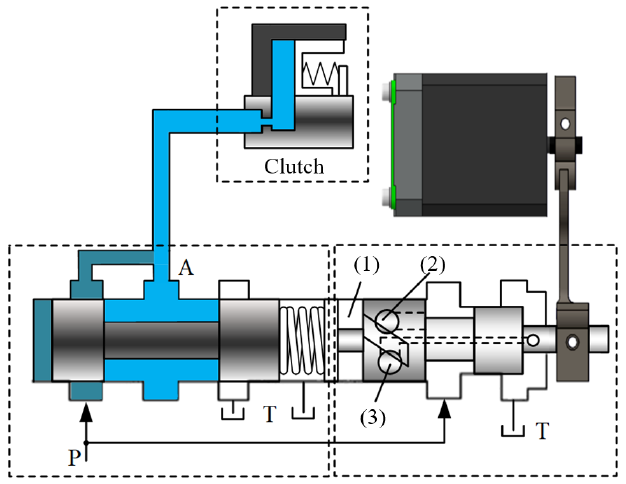
Figure 2. Diagram of 2D digital buffer valve working principle. (1) Sensitive cavity; (2) high-pressure hole; (3) low-pressure hole.